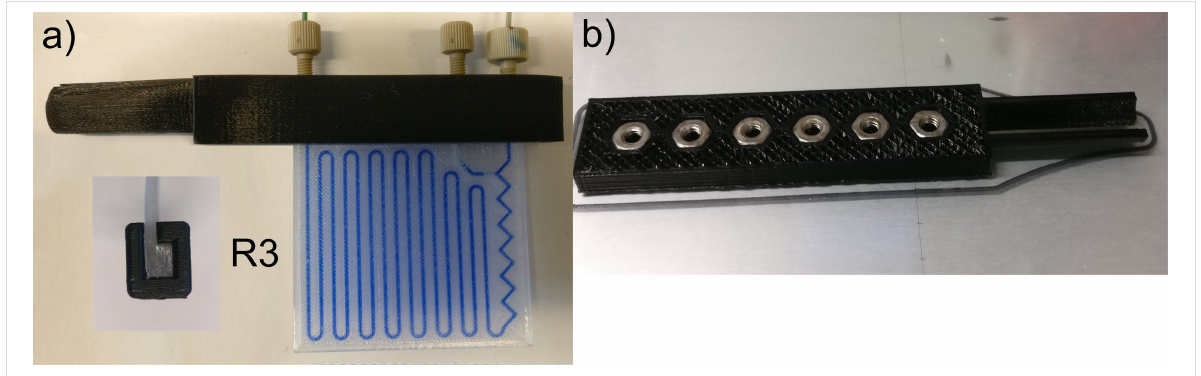
Figure 2: a) L-shaped rail made of PLA with the mounted reactor R3. The small picture shows the fixed reactor in the rail. b) In-printed screw nuts during 3D-printing: The print was paused, the nuts inserted and the print resumed.